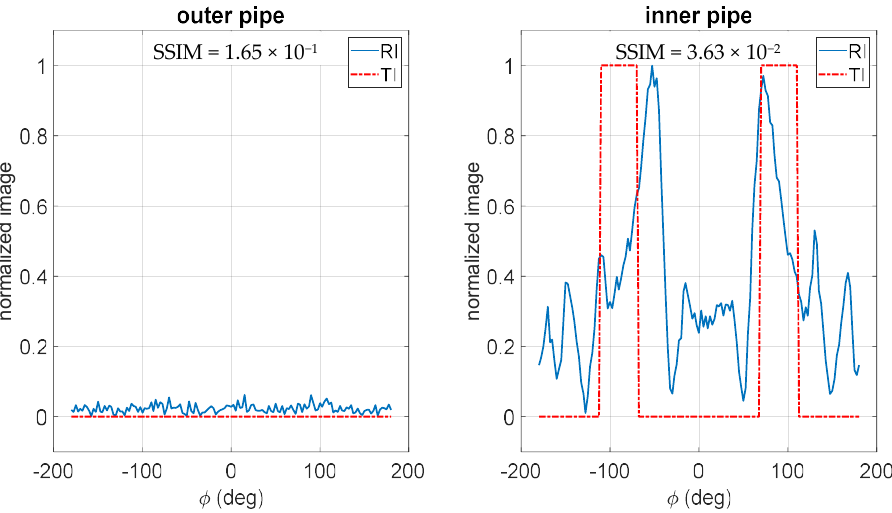
Figure 4. Reconstructed images of the larger defects (RI: reconstructed image and TI: true image).